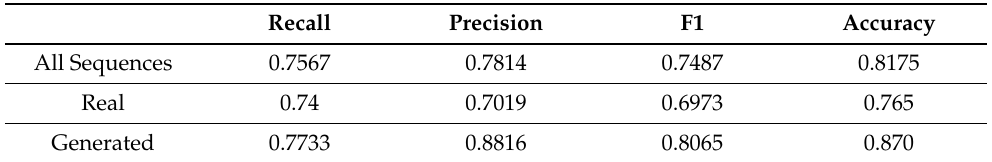
Table 3. The binary classification of physiological measurement data according to stress moments performed by